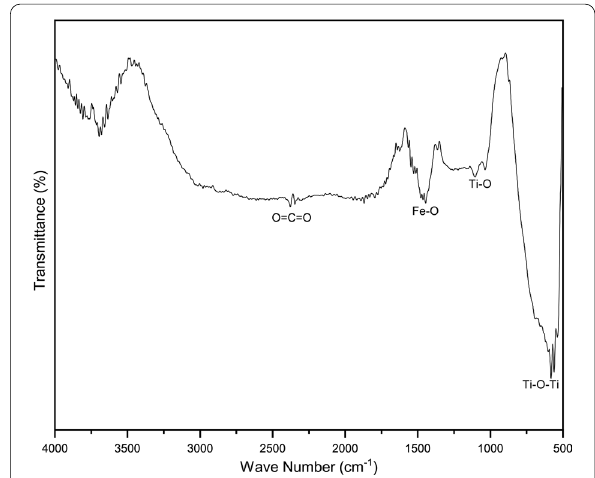
Fig. 5 FTIR spectrum of the initial ilmenite sample showing characteristic bonds